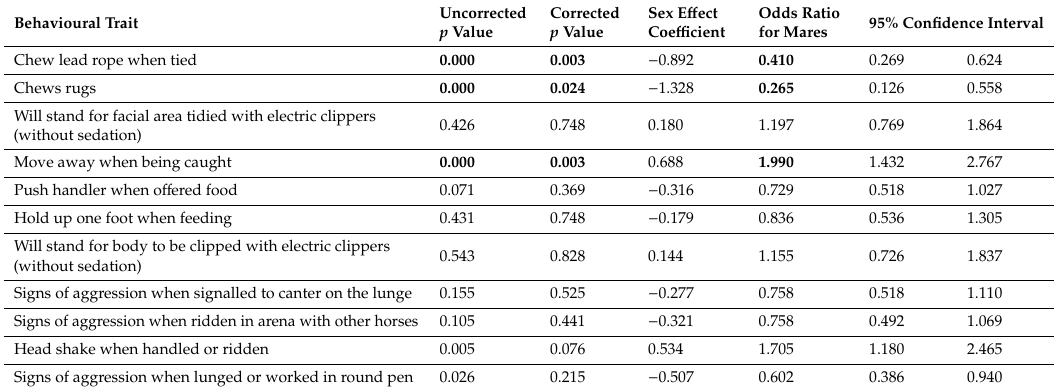
Table 3. The uncorrected and corrected sex e ff ect p values, as well as the odds ratio for mares (compared to OR = 1 for geldings). Significant di ff erences appear in bold.